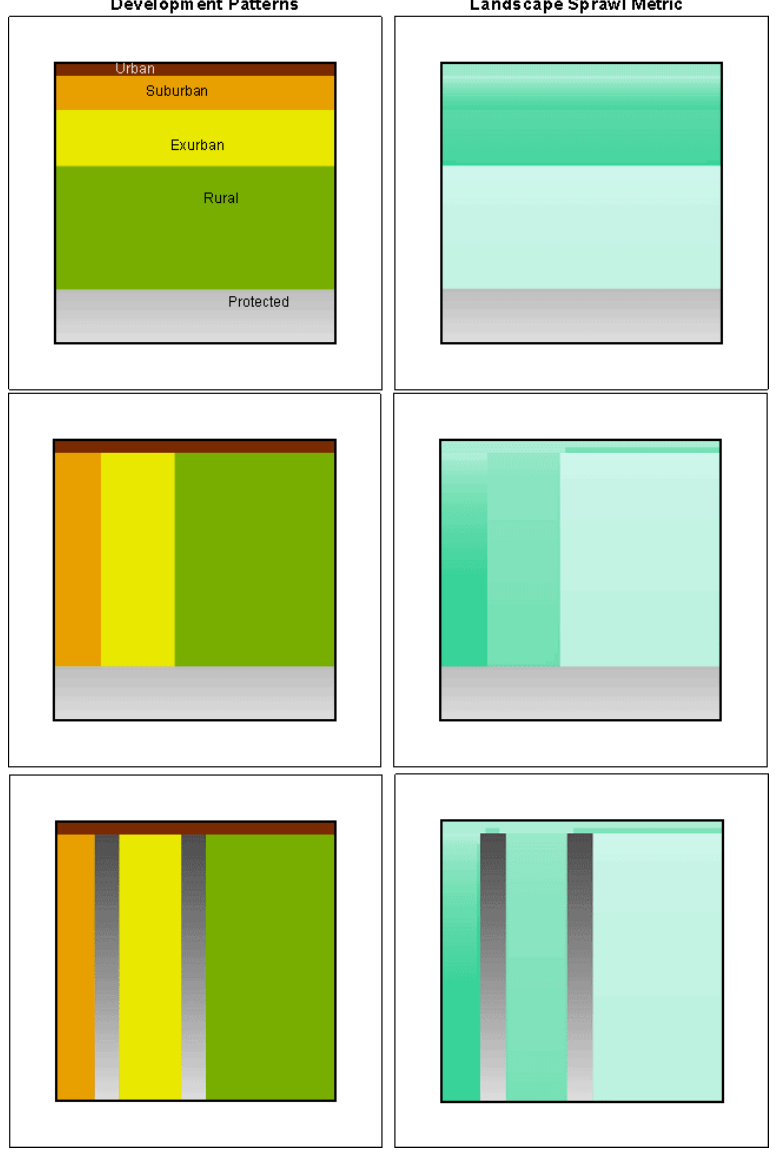
Fig. 3. An illustration of how the Landscape Sprawl (LS) metric captures different development patterns. Two additional development configurations that total the same number of housing units (center left, bottom left). The LS is computed for each cell within the 100 x 100 landscape, with higher values, represented by a darker hue, indicating more sprawl. With increasing distance from urban core (center), LS increases strongly for suburban density, moderately for exurban density, and weakly for rural areas. Note that the edge contrast weight occurs between the urban/rural and exurban/rural edge, but is clearly visible because of the higher contrast at the urban/rural edge. A general indicator of the overall sprawl score is the mean LS score for a given analytical unit. The mean LS scores increase from top to bottom: 267.8 (top), 338.9 (center), 369.8